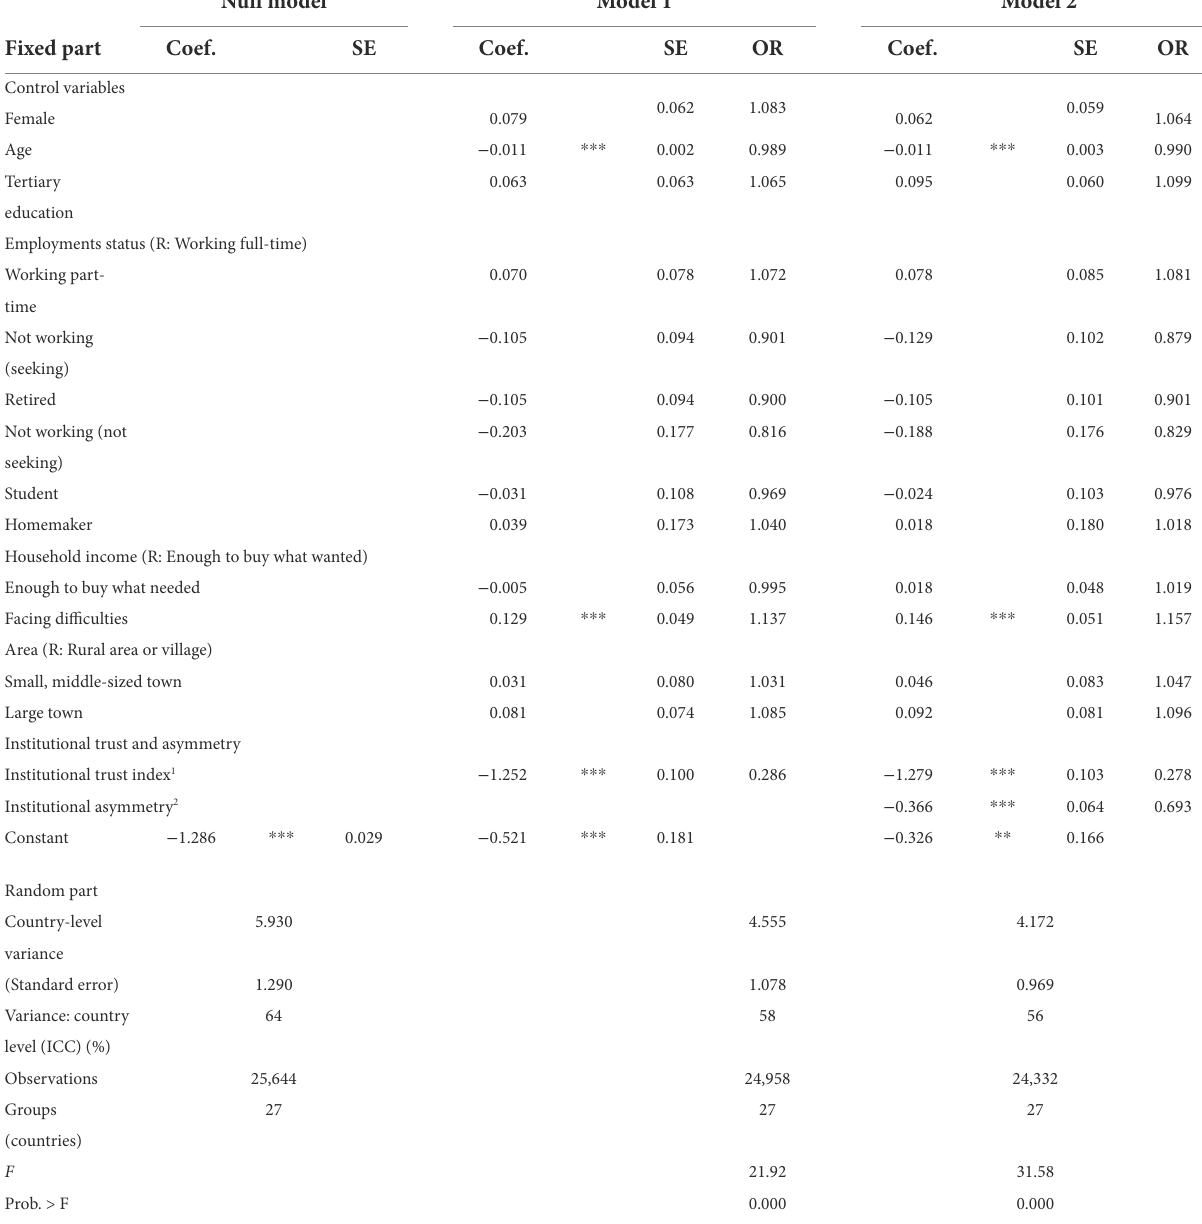
TABLE 1 Multilevel logistic regression of the patient’s likelihood to make informal payments in EU-27: the role of institutional trust and institutional